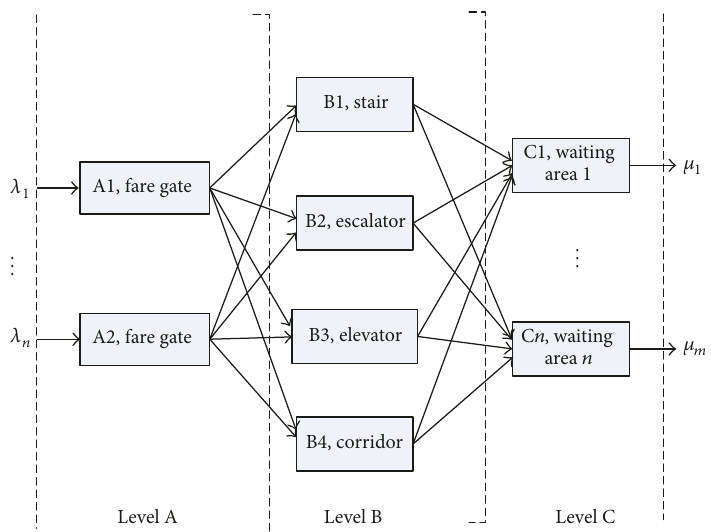
Figure 2: The queuing network structure of passenger inbound